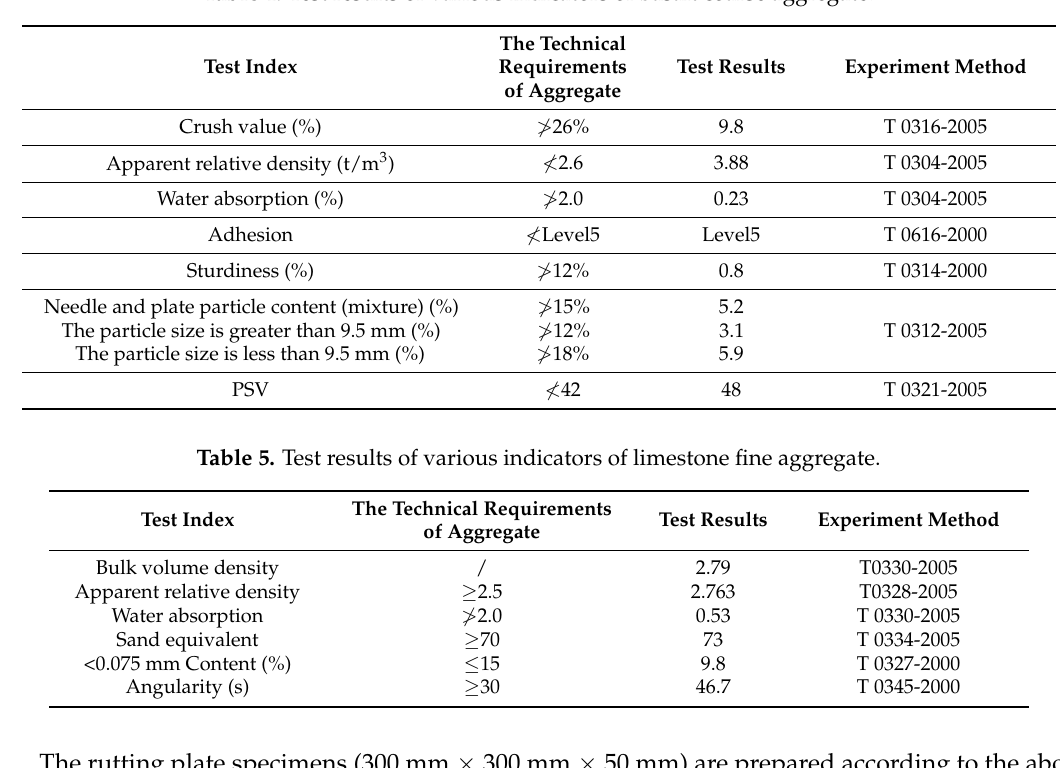
Table 4. Test results of various indicators of basalt coarse aggregate.